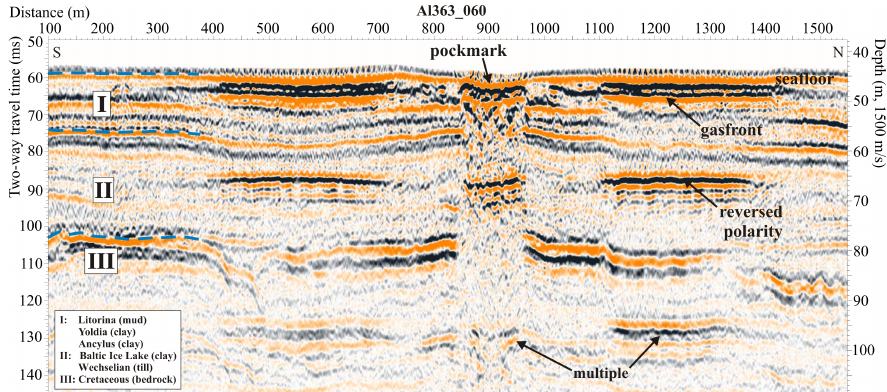
Fig. 6. Multichannel seismic profile showing a pockmark and its vicinity in the Arkona Basin. The seismic section is running from south (Lat: 54.90 ◦ N, Long: 13.61 ◦ E) to north (Lat: 54.91 ◦ N, Long: 13.61 ◦ E). The presence of free gas beneath the seabed is indicated by the reversed polarity compared to the normal polarity of the seafloor outside the pockmark. The blue lines indicate layer boundaries.